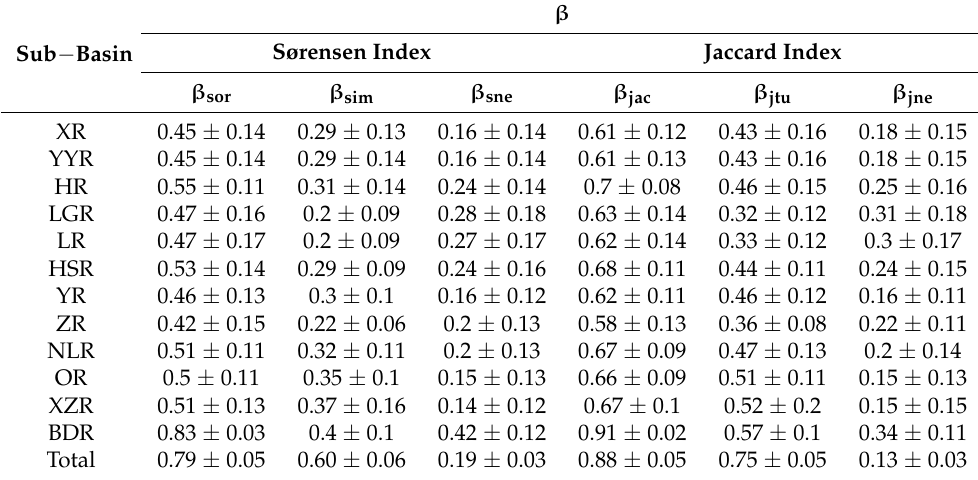
Table 3. Fish compositional similarity by BAS frameworks of 12 Sub − basins in Guangxi.